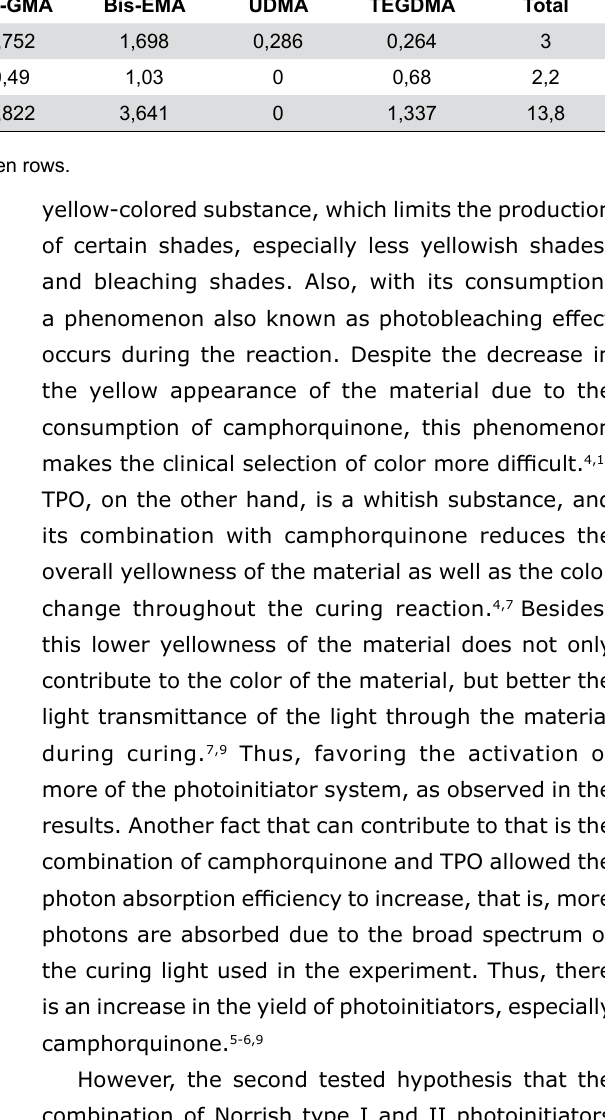
*Different letters indicate statistically significant difference in between rows. Table 4- Physical properties of the experimental composites containing the different photoinitiator Photoinitiator Degree of Conversion System